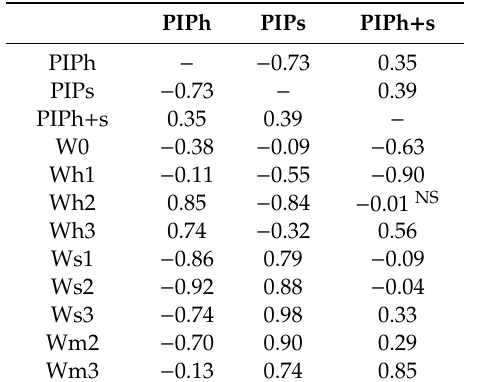
Table 2. Correlation coe ffi cients among HRF metrics ( N =